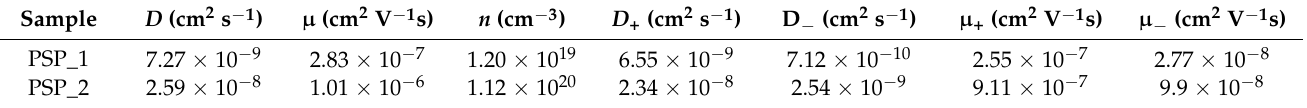
Table 4 lists the transport parameters of ions for the systems.